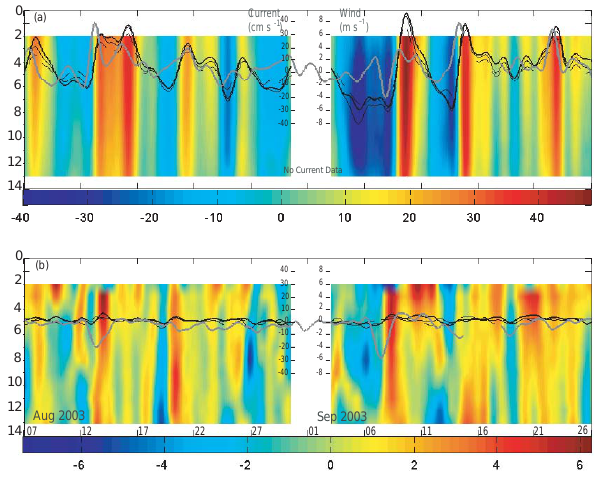
Fig. 10. Low frequency wind (thick grey line) and current across the water column and at distinguished three layers: surface, middle and bottom layers (have been shown as thick, thin and dashed lines, respectively) time series. (a) Alongshore directions; (b) cross-shore